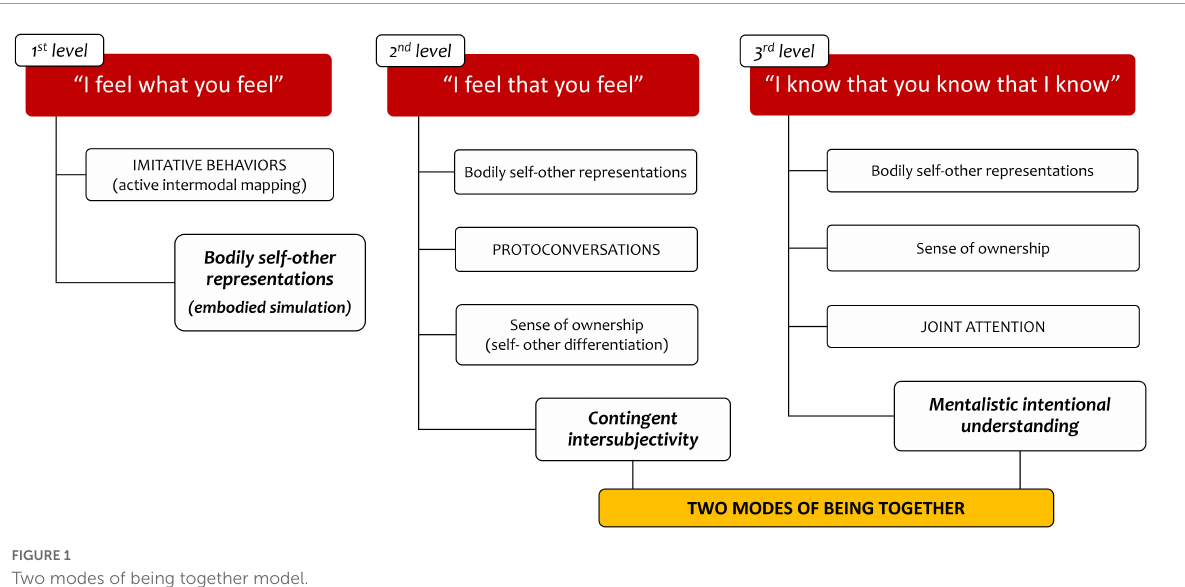
FIGURE1 Two modes of being together